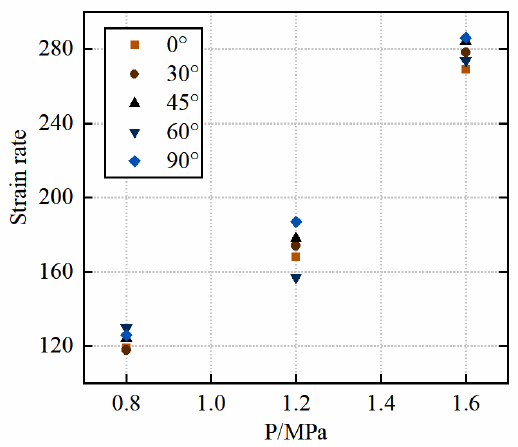
Figure 5. Correlation between strain rate and impact pressure of the samples under different load-